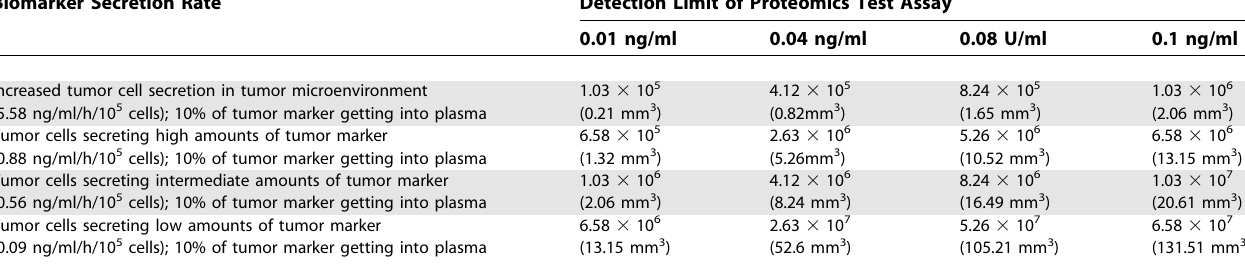
Table 8. Minimum Detectable Tumor Cell Number and Estimated Tumor Size (in mm 3 ) as a Function of PSA Proteomics Test Assay